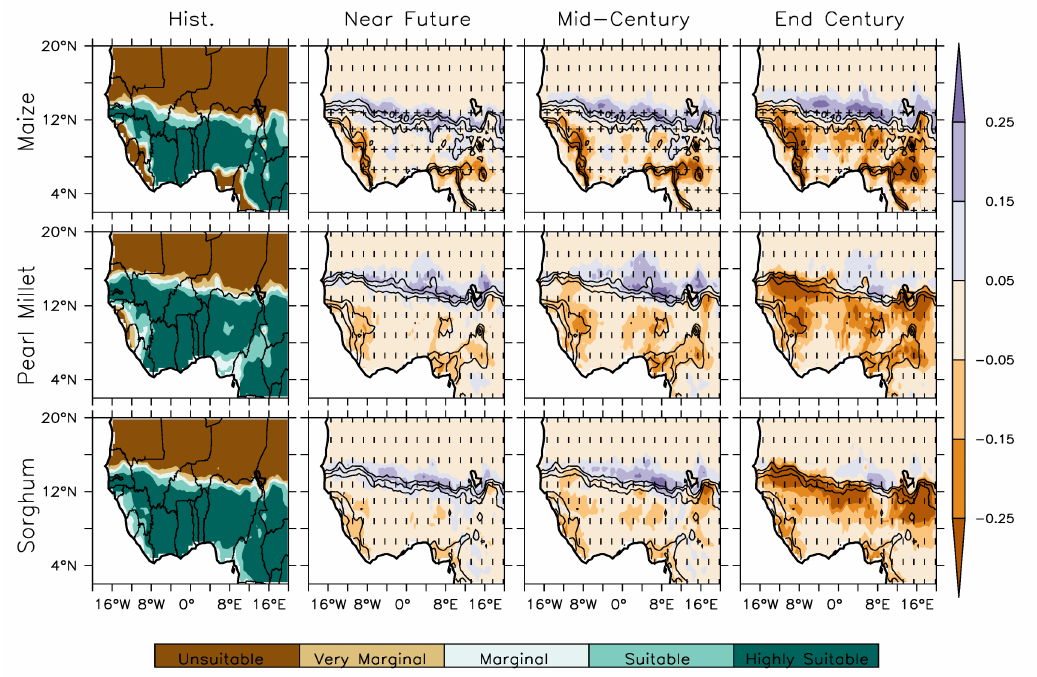
Figure 3. Simulated spatial suitability distribution for the cereal crops, maize pearl millet and sorghum over West Africa for the historical month (1981–2000) (column 1) and the projected change in the crop suitability for the near future month (2031–2050), mid-century (2051–2070) and end of century (2081–2100) (column 2–4, respectively). The vertical strip ( | ) indicates where at least 80% of the model simulations agrees on the projected sign of change while the horizontal strip ( − ) indicates where at least 80% of the model simulations agree that the projected change is statistically significant at 99% confidence level. The cross ( + ) indicates where the two conditions are met, meaning that the change is robust.